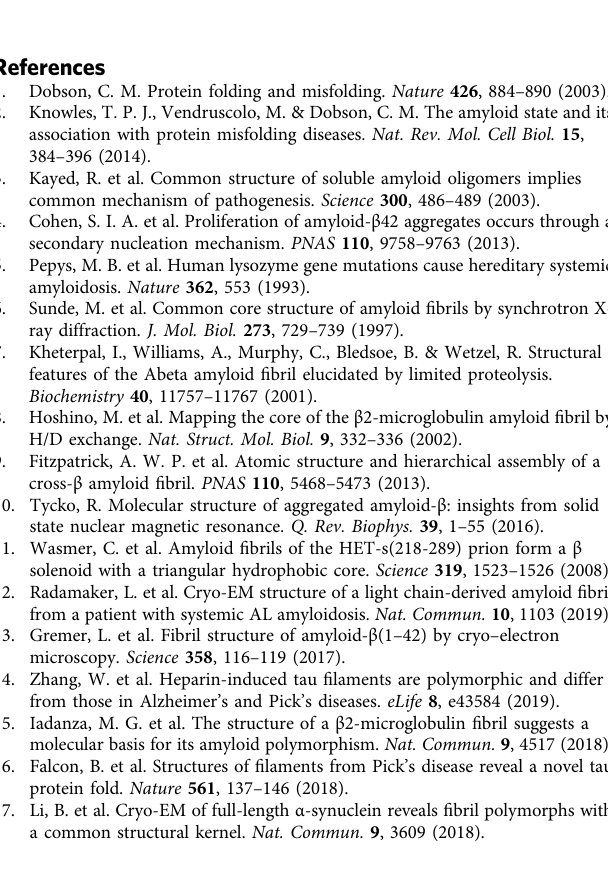
Supplementary Table 1. Molecular graphics and analyses were performed with Chimera 57